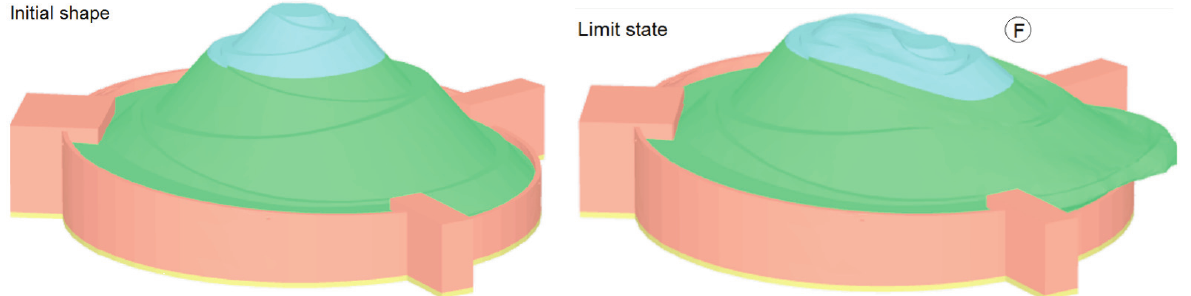
Fig. 13. Deformed mesh for the 10% reduction of cohesion and tangent of friction